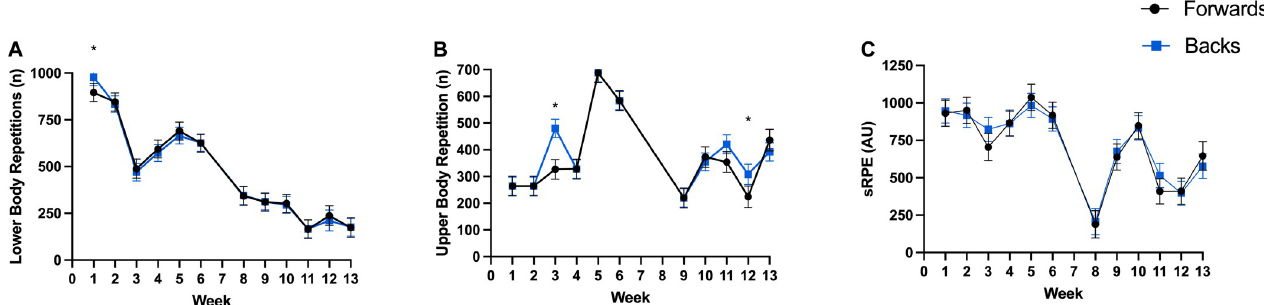
Fig 3. Total weekly gym-based training load, between positional groups, across weeks. (A) Lower body repetition volume, (B) Upper body repetition volume, (C) Session rating of percieved exertion. � Difference between forward and back playing positions (p < 0.05).